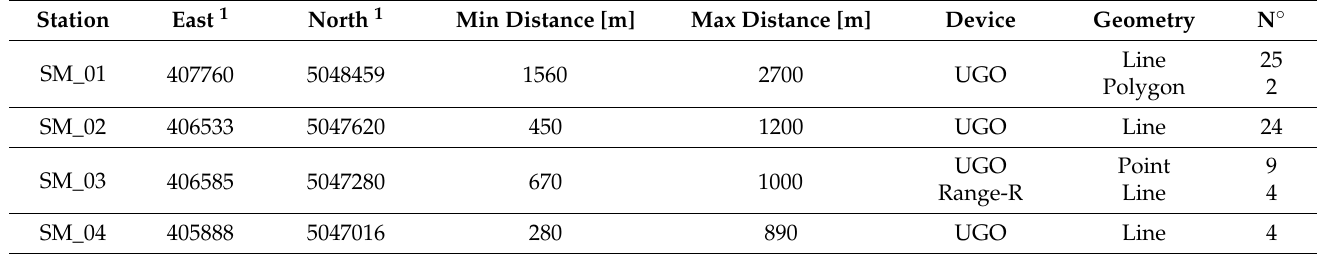
Table 5. Measure stations and